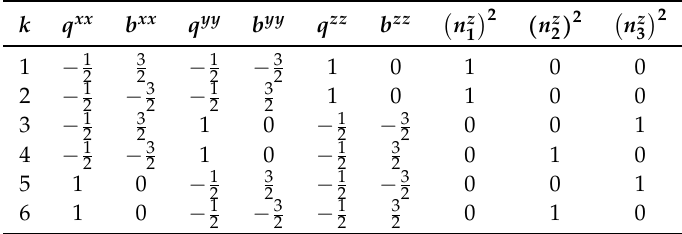
Table 1. Values of the diagonal components of the tensors q and b and of the z component of the principal axes of a generic nematogen in the six possible states ζ ( k ) of the restricted